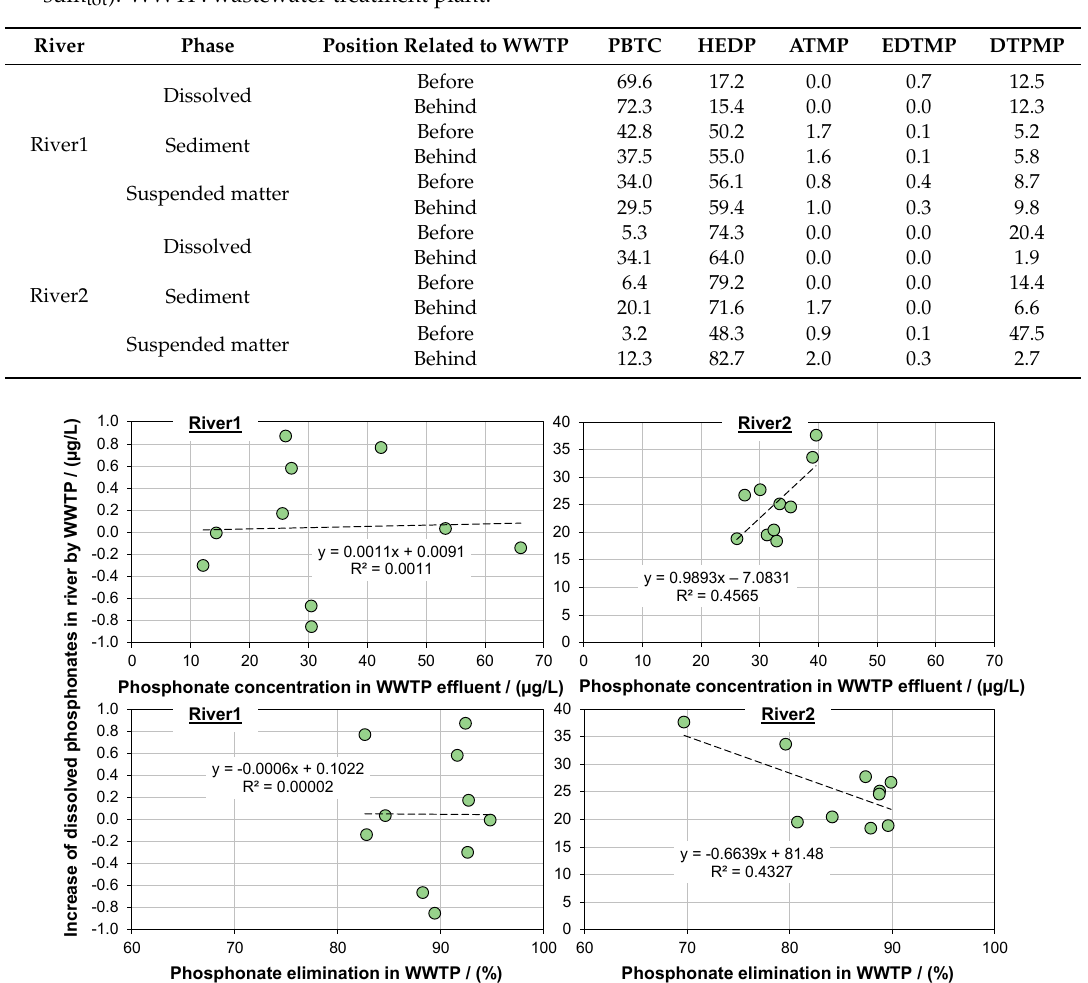
Figure 4. Increase of the total dissolved phosphonate concentrations (concentration behind minus concentration before WWDs) in both rivers as a function of the total dissolved phosphonate concentrations in the wastewater treatment plant (WWTP) effluents ( top ) and as a function of the degree of phosphonate elimination in the respective WWTPs ( bottom ) (WWTP data from Rott et al. [12]). Table 1. Contribution of single phosphonates to the total phosphonate content of the three different river phases (in % by mass) (determination: summation of the concentrations and loads of each individual phosphonate (sum ind ) and of total phosphonates (sum tot ) over all samples; quotient of sum ind and sum tot ). WWTP: wastewater treatment plant.